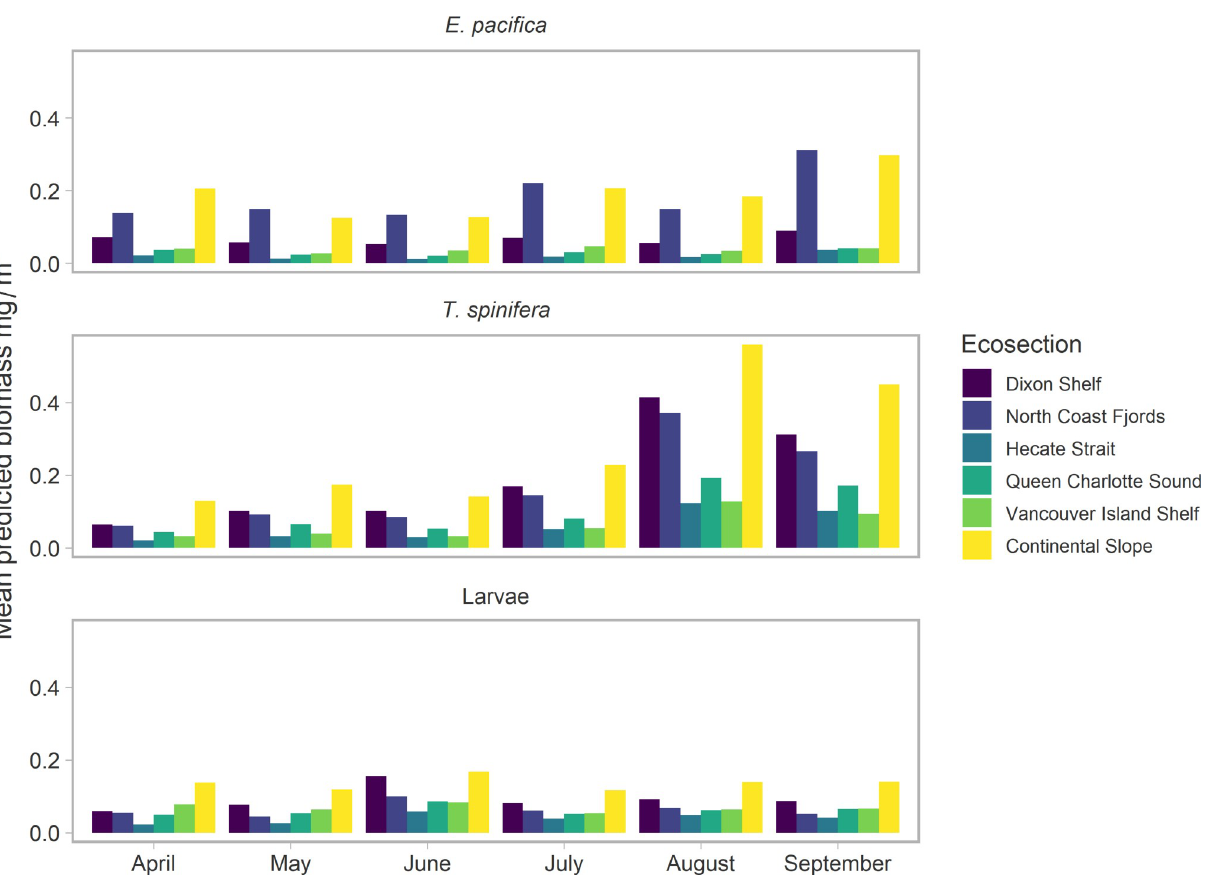
Fig 3. Mean predicted biomass mg/m 2 for each month across the prediction grid, calculated for each oceanographic ecosection displayed in Fig 1.